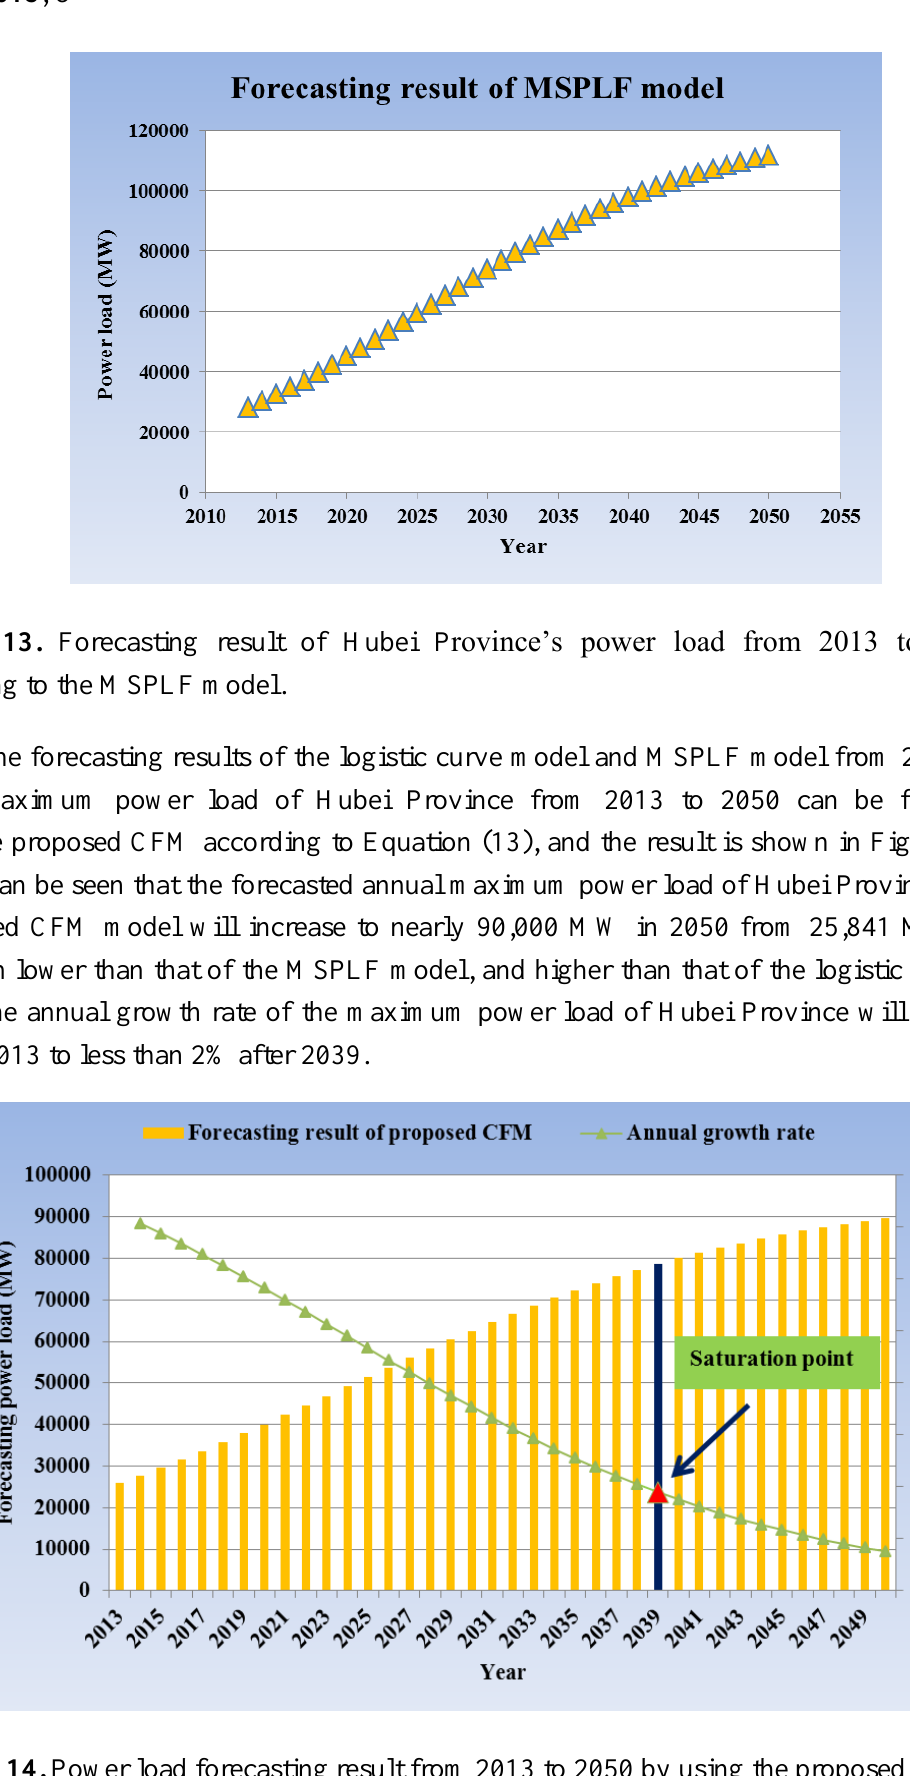
Figure 14. Power load forecasting result from 2013 to 2050 by using the proposed